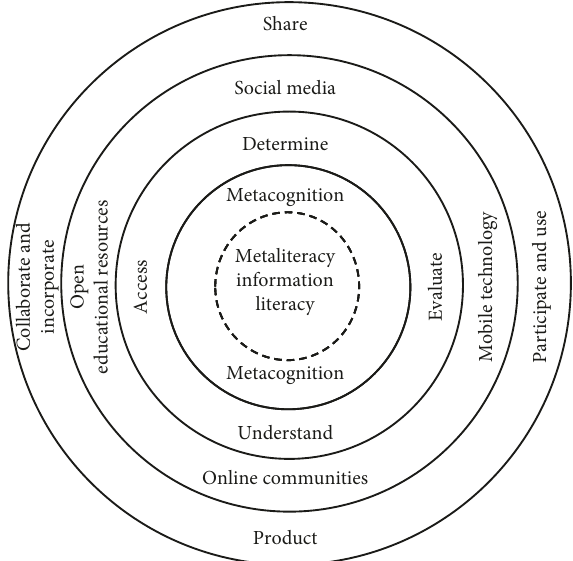
Figure 1: Metaliteracy model (adapted from